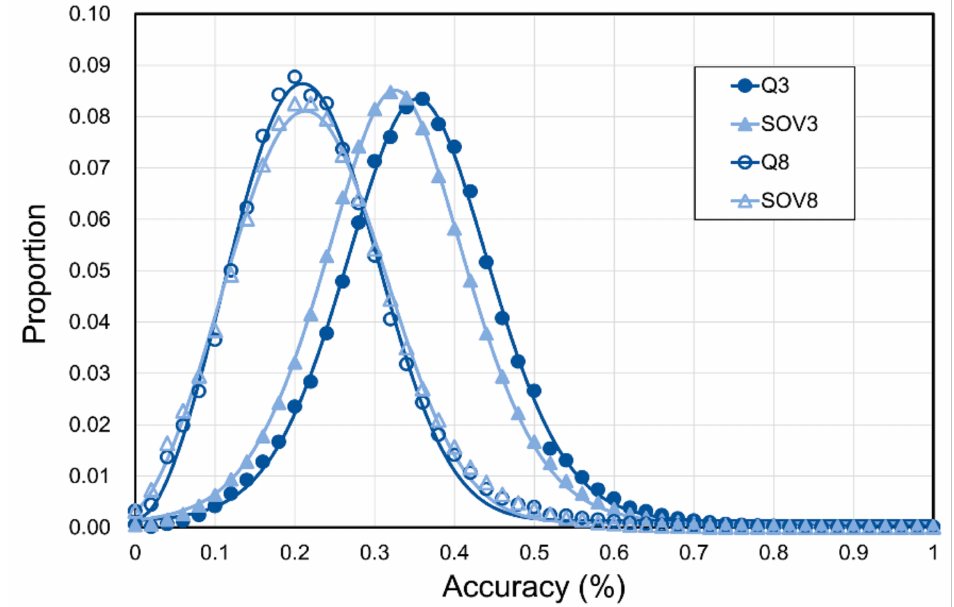
Figure 5. Distribution of secondary structural consistency between random protein pairs. One million rounds of random pairing were performed to compute the distribution of secondary structural consistencies between proteins to mark the lower bound of SSP accuracy. Two proteins were randomly selected from the SCOP-2.07 dataset in each round, and the secondary structural consistency between them was measured with the Q and SOV scores. The average SOV3 of these random pairs was lower than the average Q3 (SOV3 = 32% versus Q3 = 35%), different from the results of the first paper of SOV (SOV3 = 37% versus Q3 = 35%) [62], because the algorithm of SOV applied in this study was an updated version (v’99) [66], the value of which is lower than the first defined SOV (v’94; see Table I of [66] for